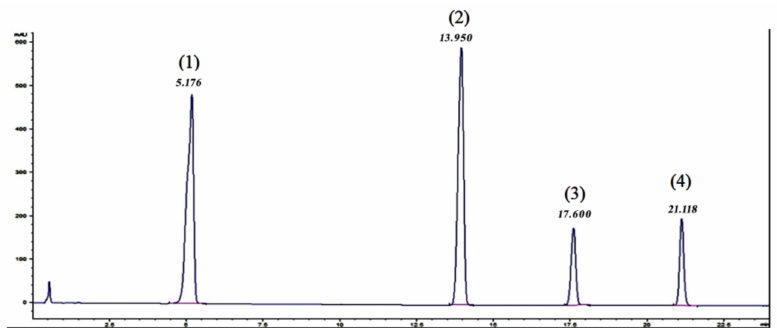
Figure 1. HPLC-DAD chromatogram of the raw material (Retention times: 5.18 min PBT cyclic dimer ( 1 ); 13.95 min PBT cyclic trimer ( 2 ); 17.60 min PBT cyclic tetramer ( 3 ); 21.12 min PBT cyclic pentamer ( 4 ).